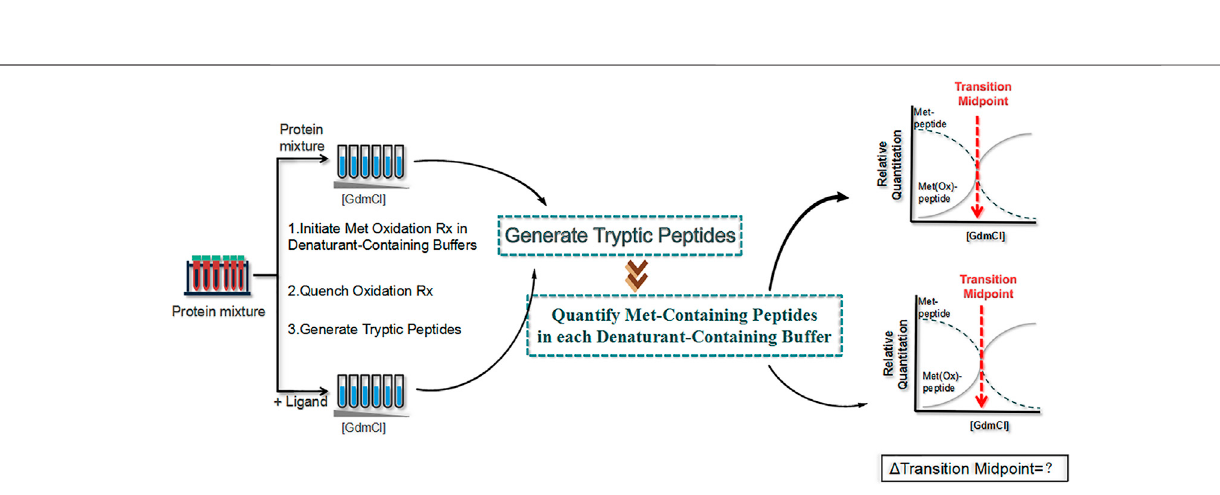
Frontiers in Chemistry |